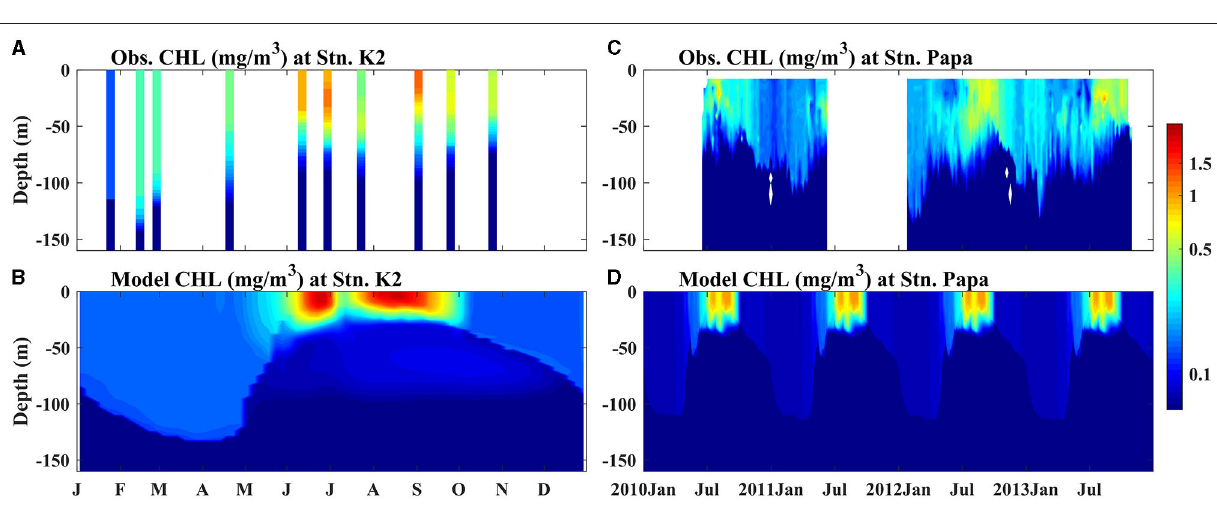
FIGURE 2 | Seasonal cycle of chlorophyll concentrations (mg/m 3 ) from (A,B) observation data and (C,D) the models for Stns. K2 and Papa. (A) Shows the observed values from every cruise observation from 2005 to 2013 at Stn. K2 and (B) shows the observed values from floats 6400 and 7601 during 2010–2013. The black dashed lines represent the